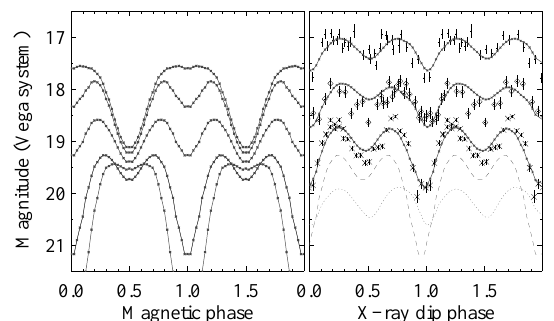
Figure 3: Simulated and observed light curves of RS Cae. Left: UBV RI models (bottom to top), de- rived from the spectra in Fig. 2. Right: SMARTS/ B , XMM-Newton/ U and UVW1. Dashed: cyclotron emis- sion, dotted: white dwarf and accretion